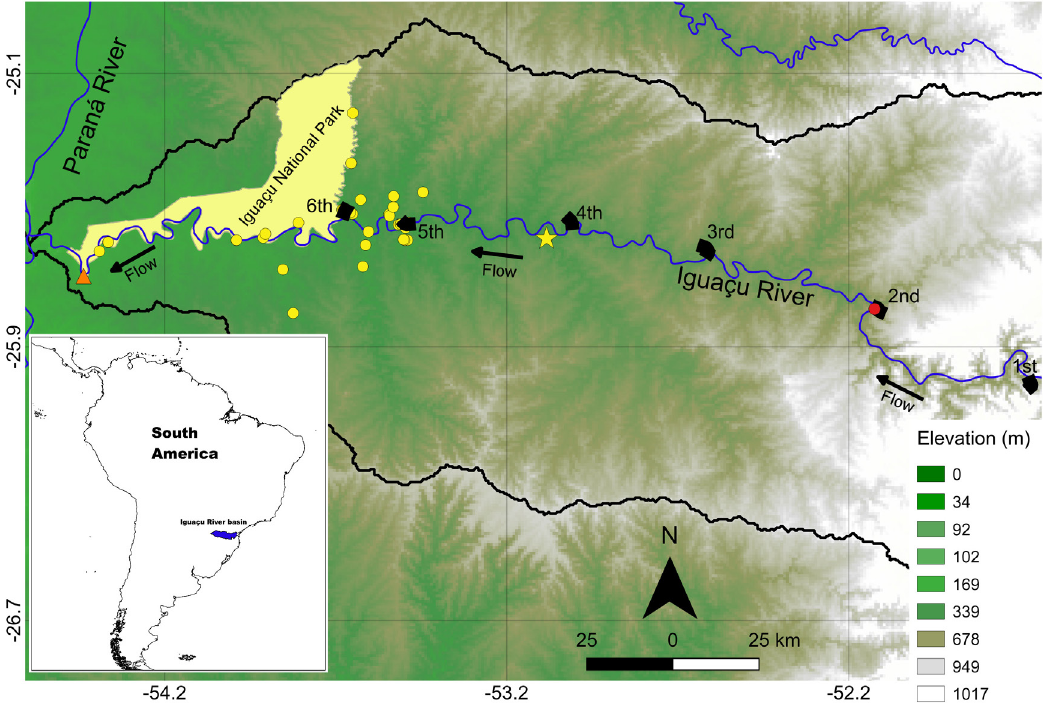
Figure 2. Map highlighting the Iguaçu River basin in South America. 1st = Foz do Areia Dam; 2nd = Segredo Dam; 3rd = Salto Santiago Dam; 4th = Salto Osório Dam; 5th = Salto Caxias Dam; 6th = Baixo Iguaçu Dam. Red dot represents the site where the non-native Zungaro jahu was captured in the Segredo Reservoir. Yellow star represents the type locality of the endemic catfish Steindachneridion melanodermatum and yellow dots represent the main sites that are effective sanctuaries to this species. Orange triangle represents the Iguaçu Falls located in the Iguaçu National